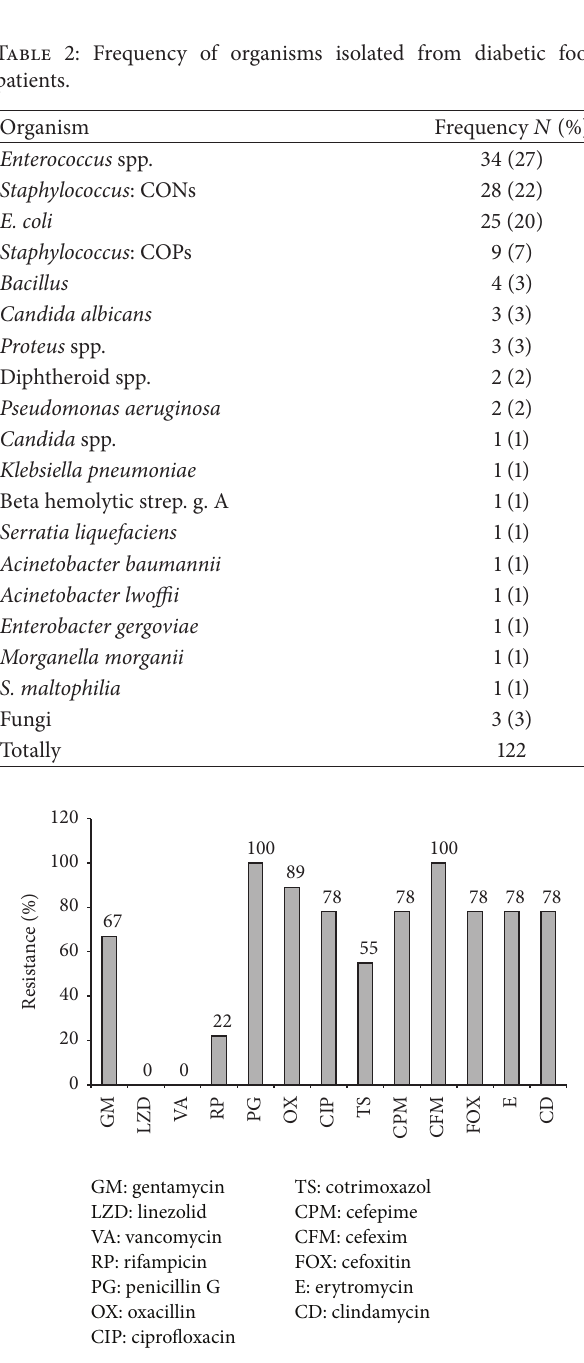
Figure 1: Antibiotic resistance patterns of S. aureus isolated from diabetic foot